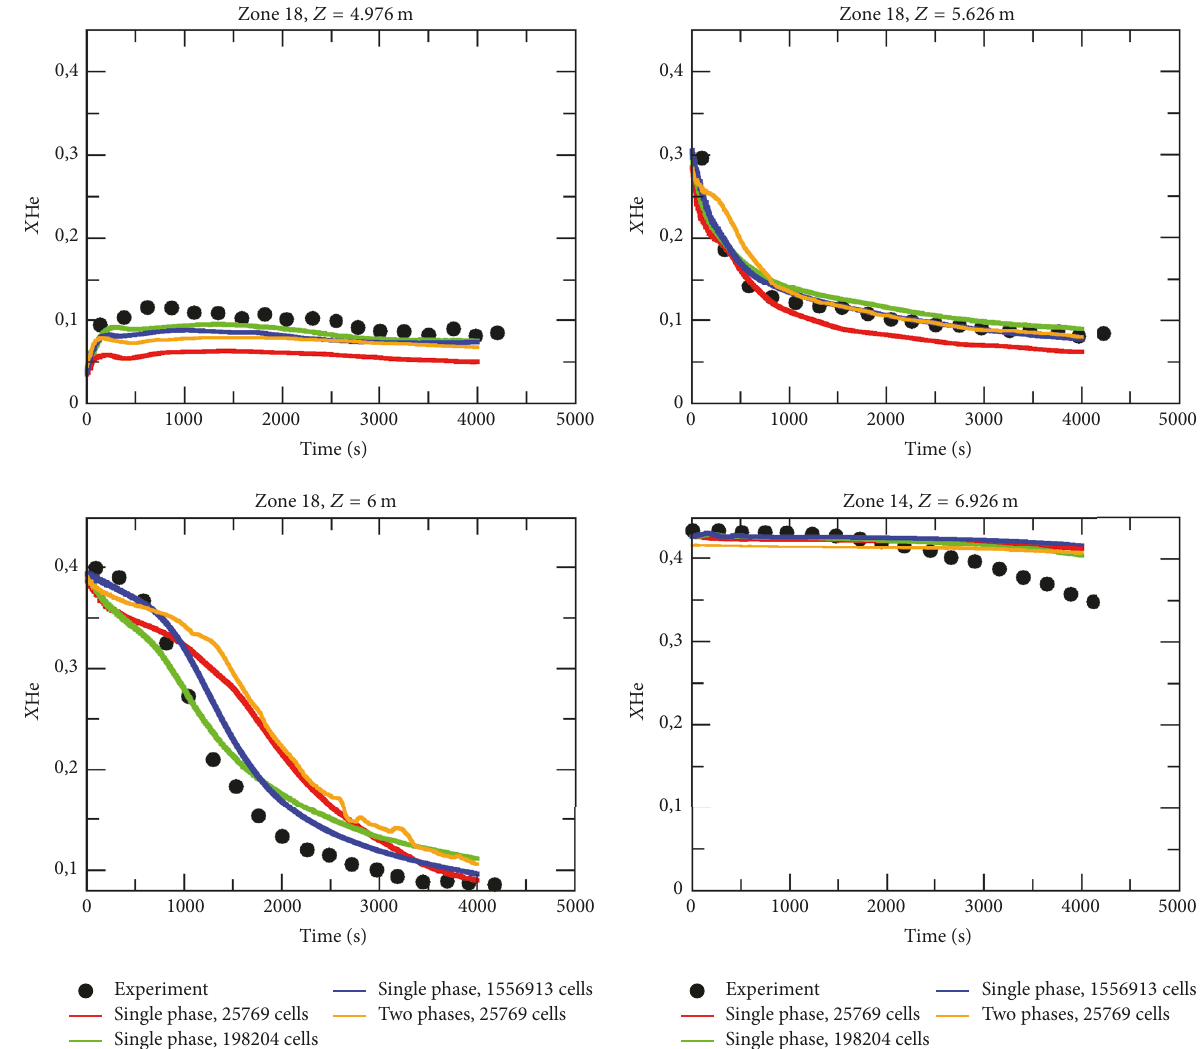
Figure 5: Helium concentration along the time for probes on zone 18 in PANDA ST1 7; “single phase” stands for Code Saturne and “two phases” stands for NEPTUNE CFD